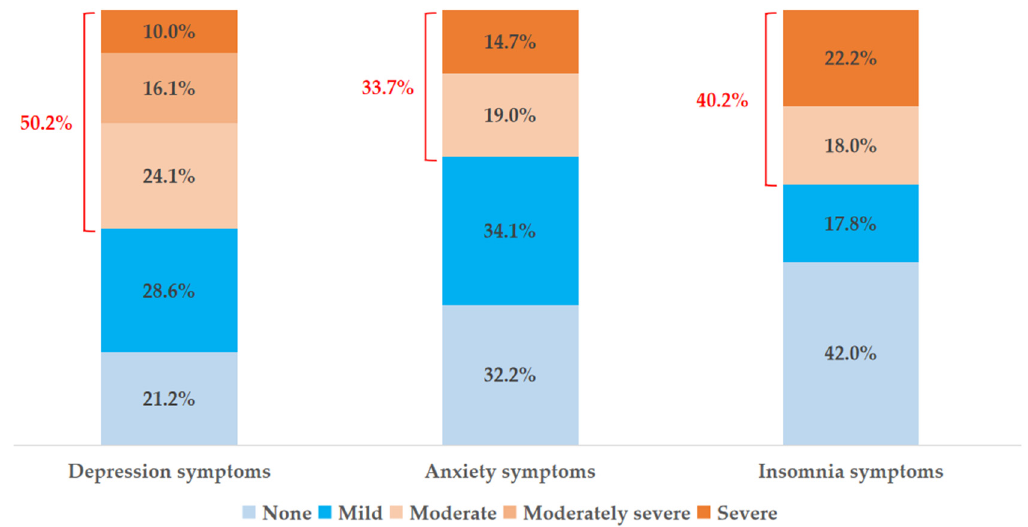
Figure 2. The prevalence of different severities of depression, anxiety, and insomnia symptoms in Chinese adolescents with frequent peer victimization experiences. Table 2. Multiple linear regression of various independent variables on depression, anxiety, and insomnia symptoms. Depression Symptoms Anxiety Symptoms Insomnia